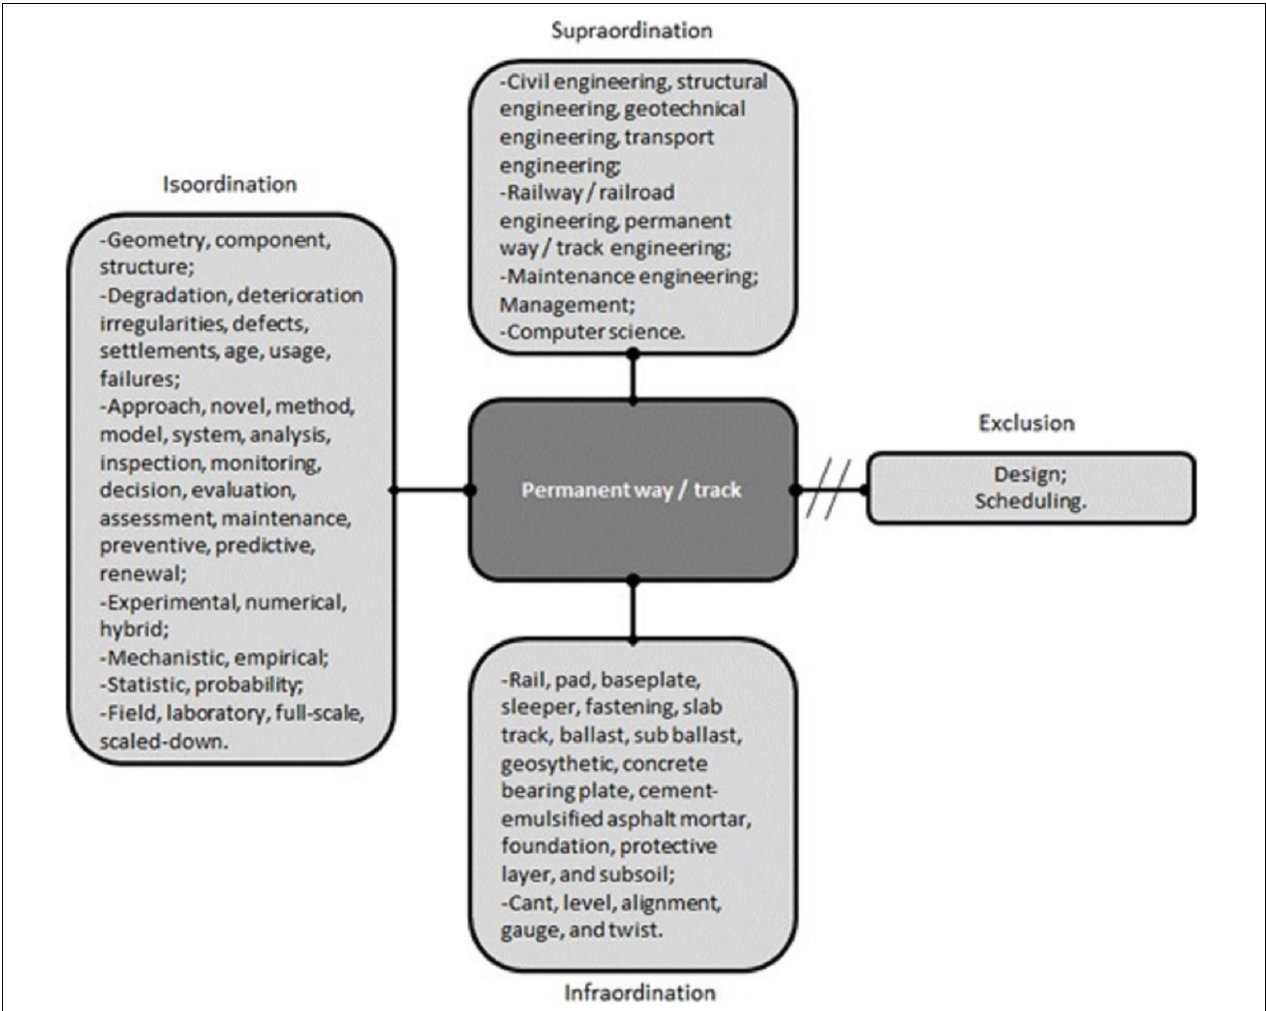
FIGURE 2 | “Mentefacto conceptual.”